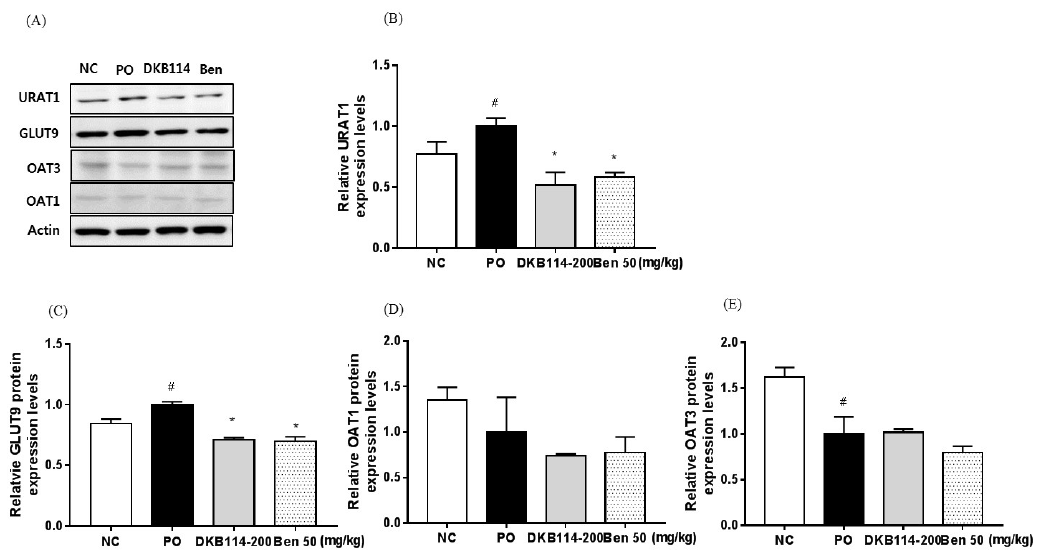
Figure 4. Effects of DKB114 on the expression of uric acid transporters in kidney of rats with PO-induced hyperuricemia. ( A ) Representative proteins expression levels determined by western blot. ( B ) URAT1, ( C ) GLUT9, ( D ) OAT1, and ( E ) OAT3 protein expression levels. Kidney tissue for analysis of protein expression levels was harvested in Exp2. NC, normal control group; PO, potassium oxonate-induced hyperuricemia group; DKB114, a mixture of ethanol extracts of Chrysanthemum indicum Linne flower (CF) and Cinnamomum cassia (L.) J. Presl bark (CB) in a 1:2 ratio; Ben 50: 50 mg/kg benzbromarone. Data are expressed as the mean ± SEM ( n = 6). # p < 0.05 vs. the NC group; * p < 0.05 vs. the PO group.